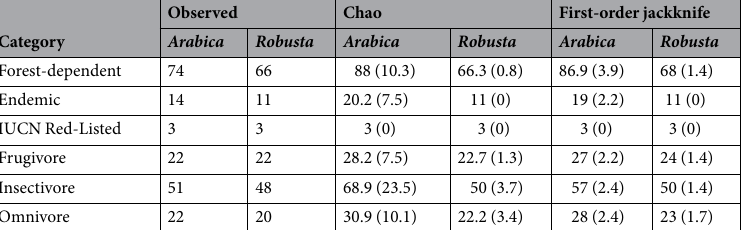
Table 2. Asymptotic richness for avian groups categorized by habitat specialization or threat across arabica and robusta stands. Observed: Observed richness in each habitat type across all point count stations. Chao (standard error) corresponds to the Chao 2 estimator of asymptotic richness. The first-order jackknife (standard error) is another asymptotic richness estimator.